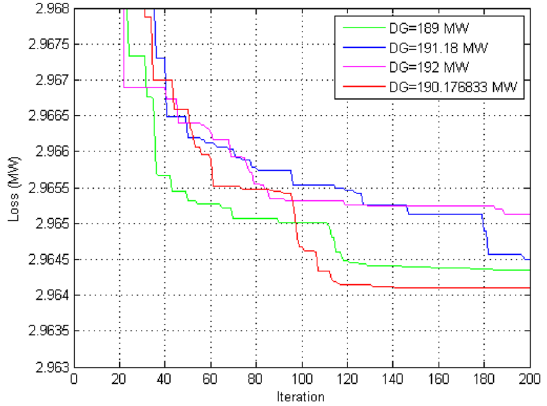
Fig. 7 Convergence characteristics with different DG power placed at bus no. 4 of IEEE 14 bus system using JAYA